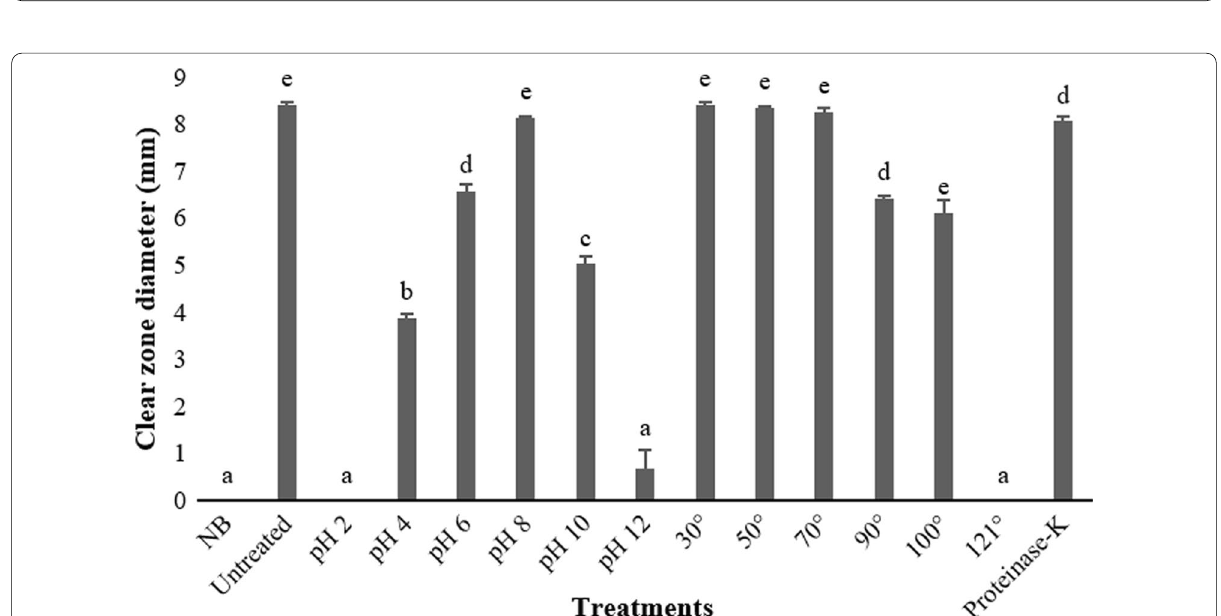
Fig. 5 Inhibitory activities of the untreated and treated cell-free supernatant (CFS) of bacterial isolate (B1) against Xanthomonas citri subsp. citri (XCC). Different letters on each histogram indicated any difference in clear zone diameter among treatments ( p <